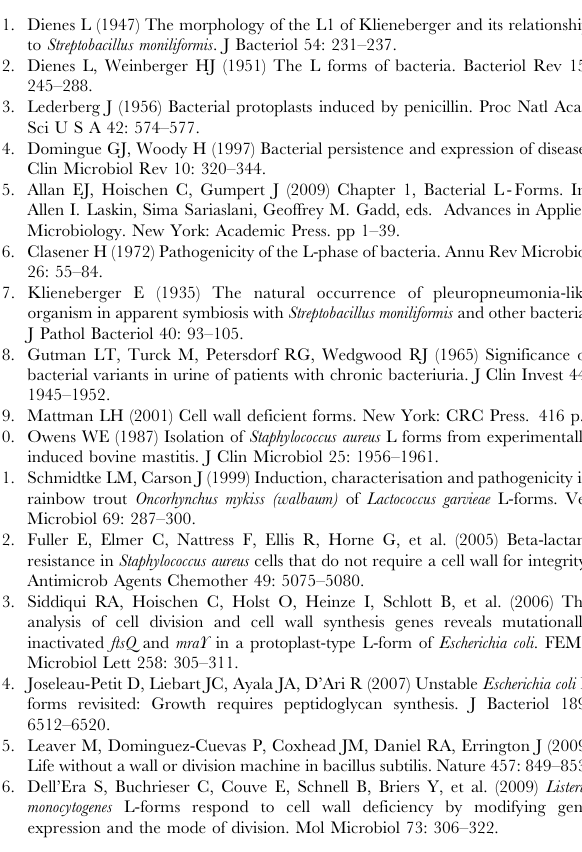
Table S4 Primers used for real-time